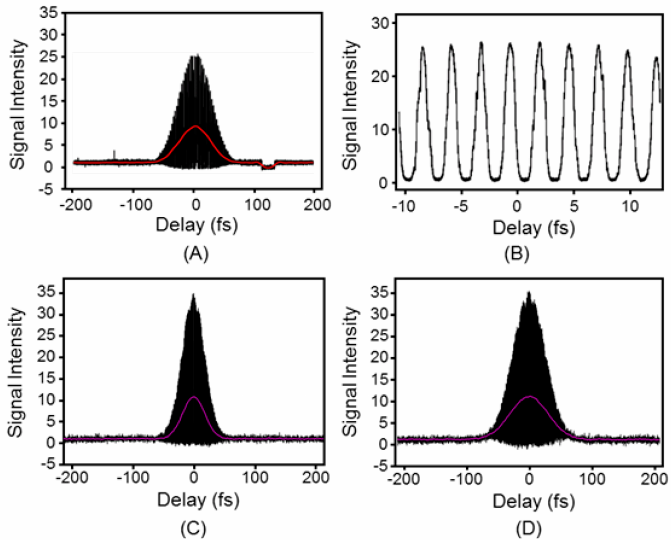
Figure 3. Autocorrelation trace for ( A ) observed data ( B ) expanded view ( C ) theoretically predicted trace for a Fourier-transform-limited (FTL) pulse ( D ) theoretically predicted trace for a chirped pulse (GDD = 500 fs 2 ). A random noise was calculated using a computer and was added to the calculated data for better visual comparison. In order to check the baseline level of the observed trace (A), the laser beam was interrupted during a period of 110–130 fs in the experiment, suggesting that the signal was suppressed to zero at the bottom of the